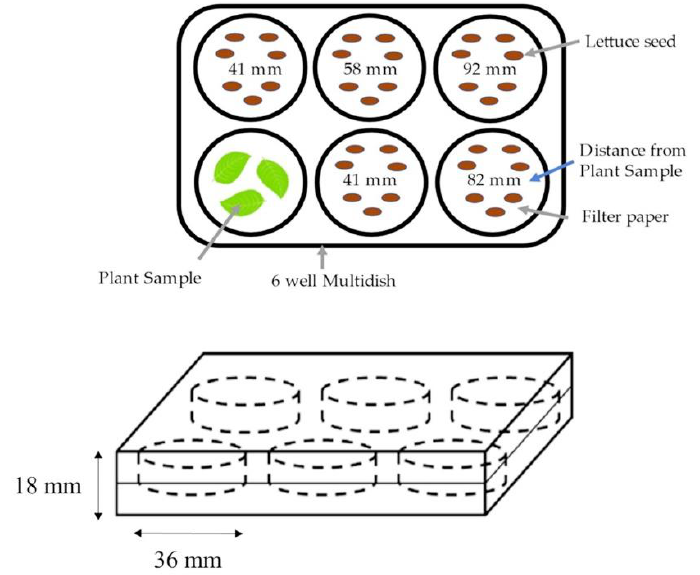
Figure 1. The views of multi-well dishes with six wells used in the dish pack